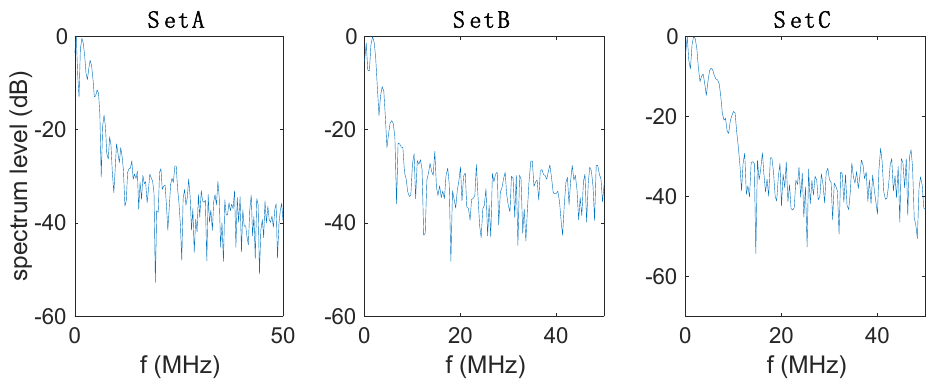
Figure 12. Frequency spectra for signals received at point 1 (Figure 11a) for process parameter sets A, B, C.